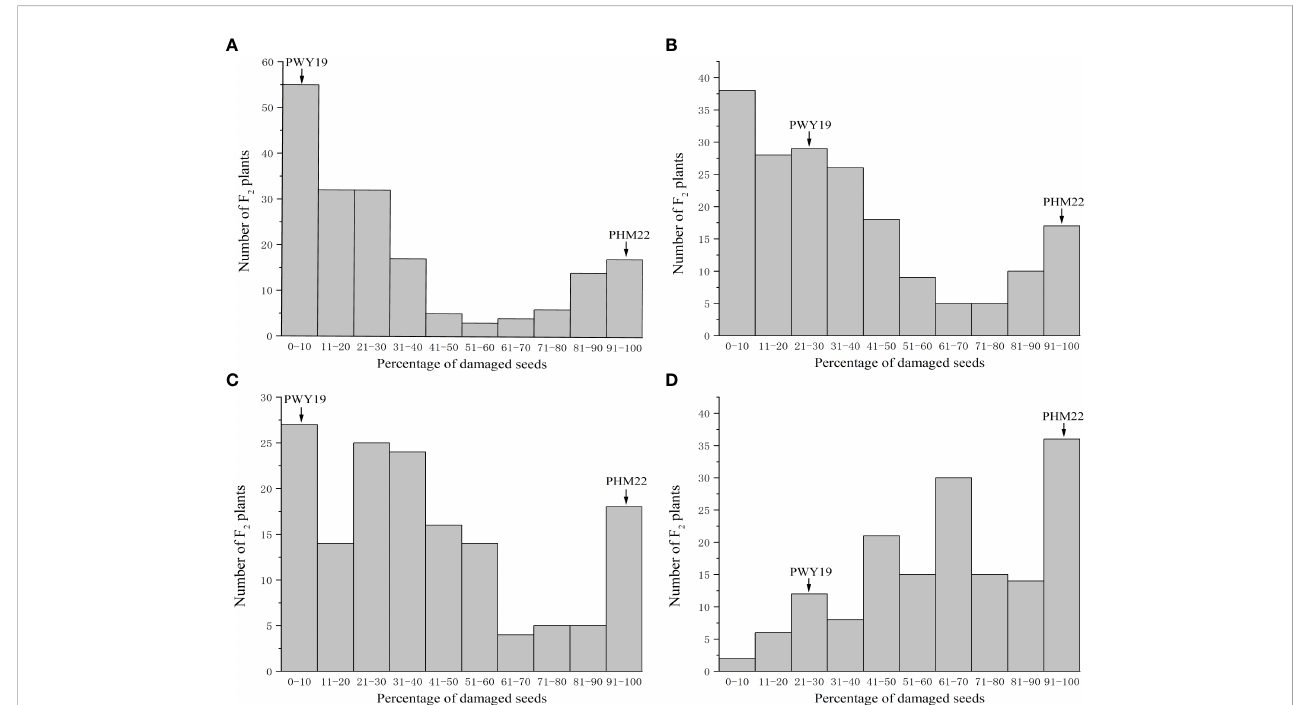
FIGURE 2 Frequency distribution of percentage of damaged seeds caused by C chinensis (A) and C maculatus (B) in the F 2 population F2Y comprising 185 individuals grown in Youyu, and C chinensis (C) and C maculatus (D) in the F 2 population F2N consisting of 159 individuals grown in Nanjing. The F 2 populations are derived from a cross between PWY19 and